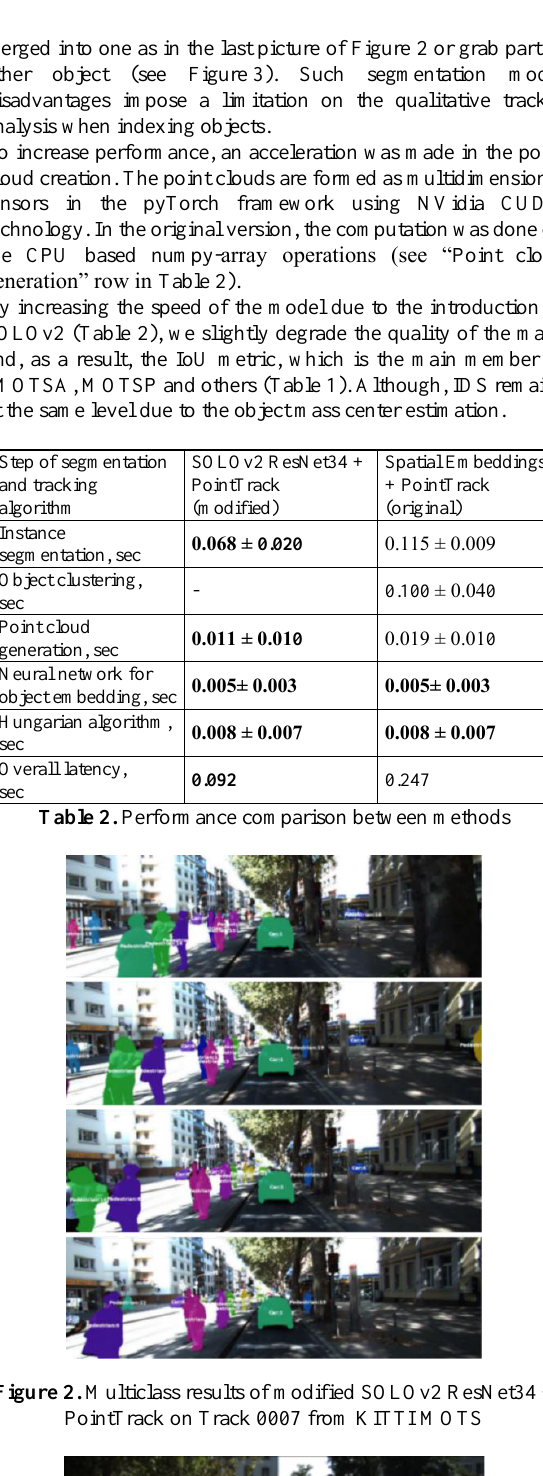
(b) Spatial Embeddings + PointTrack (original) Figure 4. Tracking results comparison between methods on 0002